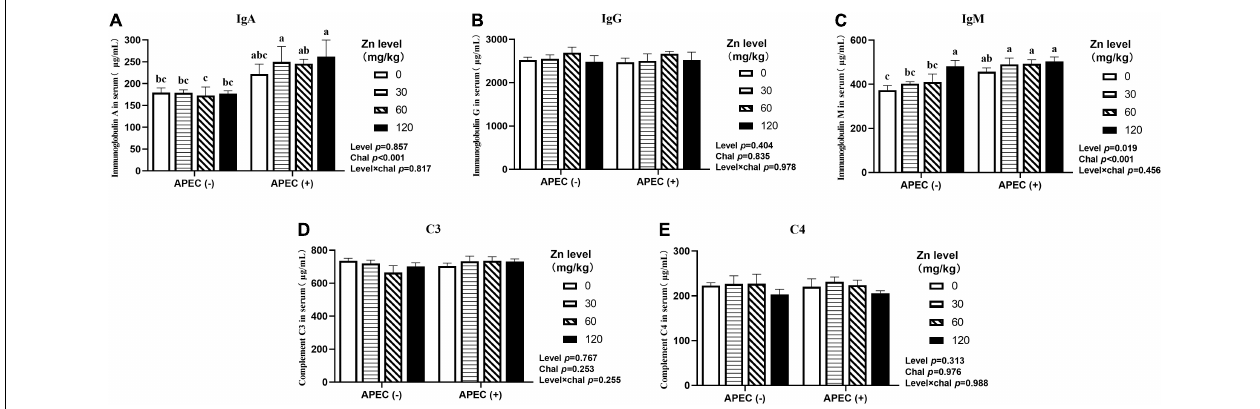
FIGURE 1 | Effect of dietary Zn–Met levels on serum levels of IgA (A) , IgG (B) , IgM (C) and complement C3 (D) and C4 (E) of meat duck challenged with APEC O78 (2 DPI). Bars with different letters are statistically significant ( P < 0.05). Results are expressed as mean ± SEM ( n = 6).